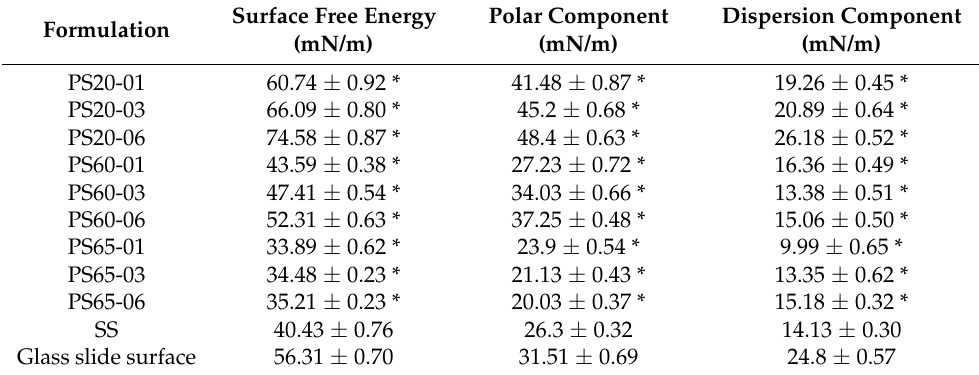
Table 2. Surface free energy and its components obtained by sessile drop measurement.